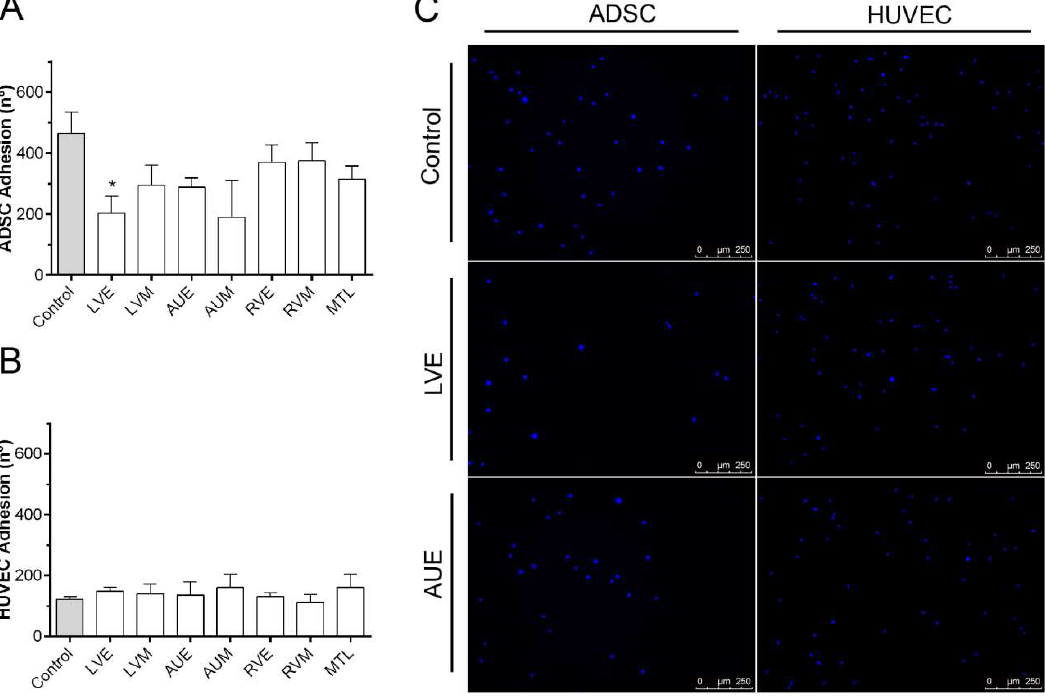
Figure 3. Influence of hH-EVs derived from cardiac regions on human adipose-derived stem cell (ADSC) and human umbilical vein endothelial cell (HUVEC) adhesion. Quantification of adhered ( A ) ADSCs and ( B ) HUVECs stimulated by hH-EVs. ( C ) Representative images of adhered cells after 20 min of treatment with extracellular vesicles derived from the left ventricular endocardium (LVE) and control without vesicles. Scale bar = 500 µm. * p < 0.05.